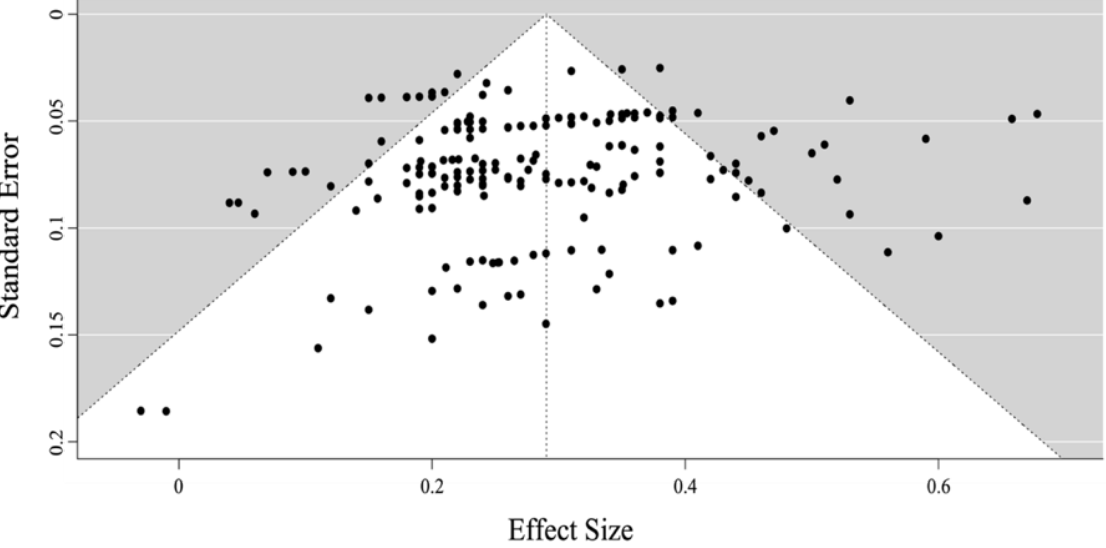
Figure 2. Funnel Plot of standard errors by correlation effect size.